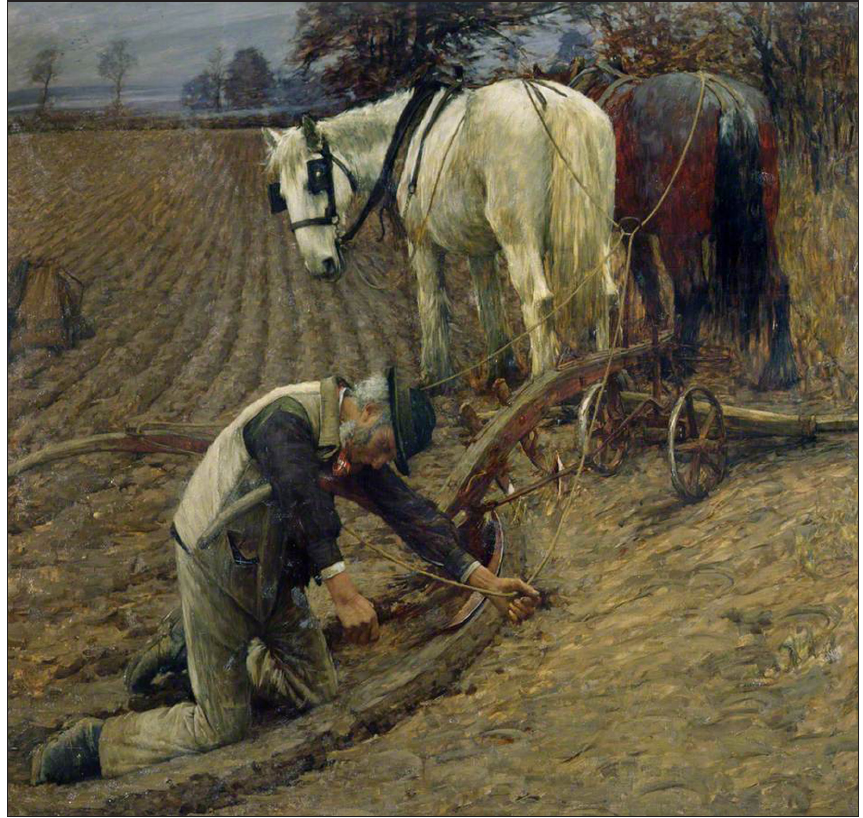
Fig . 8 : Henry Herbert La Thangue, The Last Furrow , 1895, oil on canvas, 201.5 × 214.5 cm, Gallery Oldham/Bridgeman